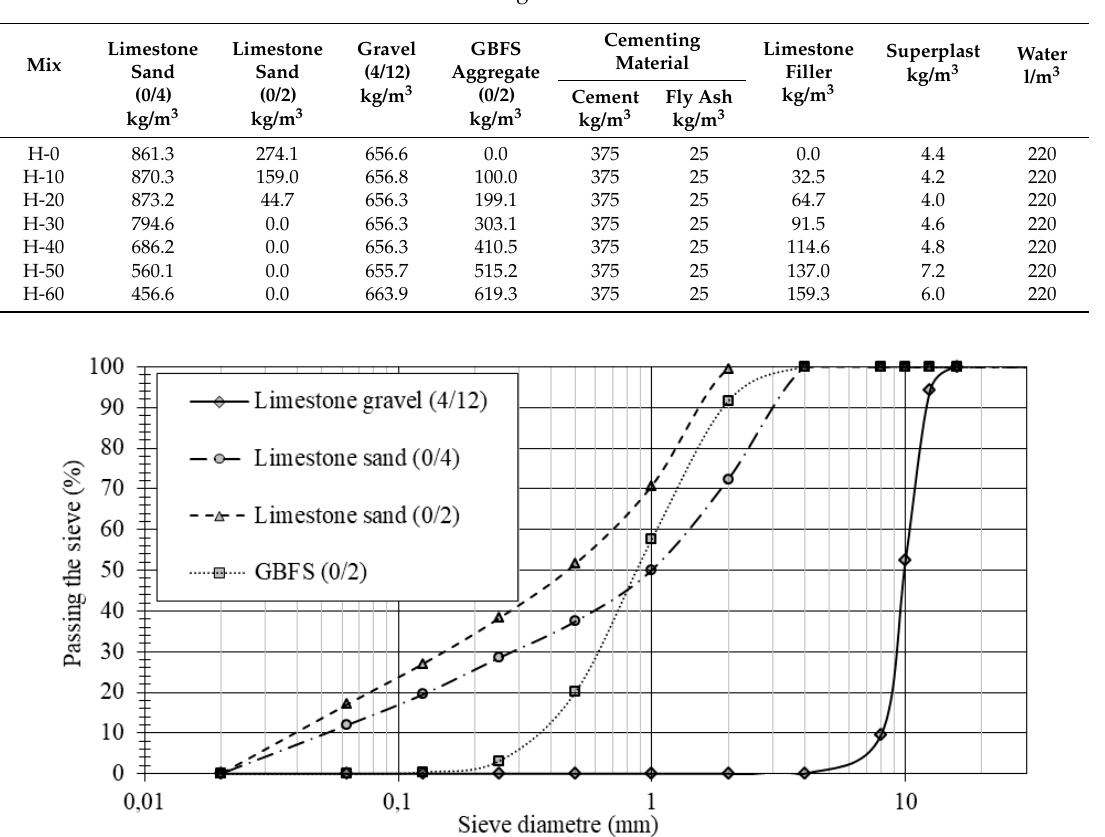
Figure 1. Granulometric curves of the different aggregates.